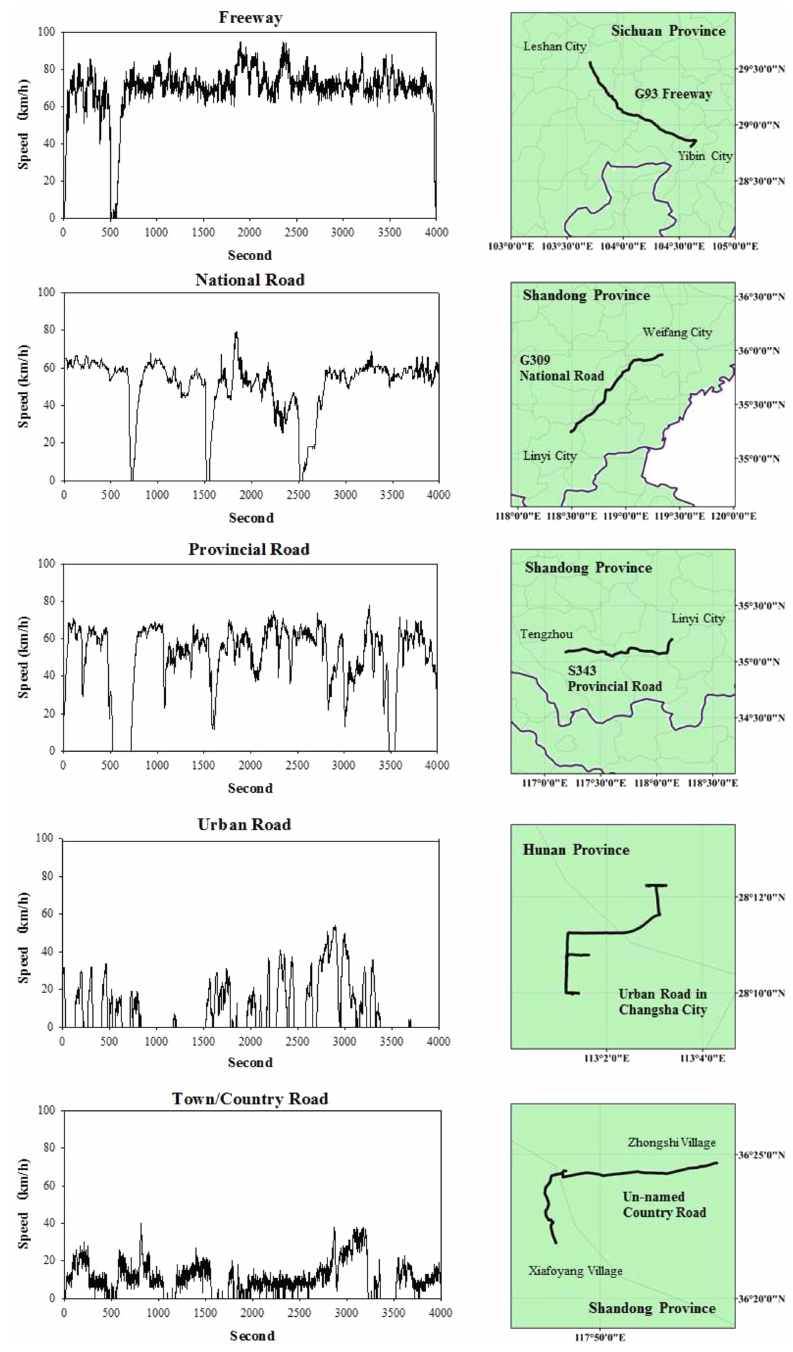
Figure 1. Speed and route of different types of tested